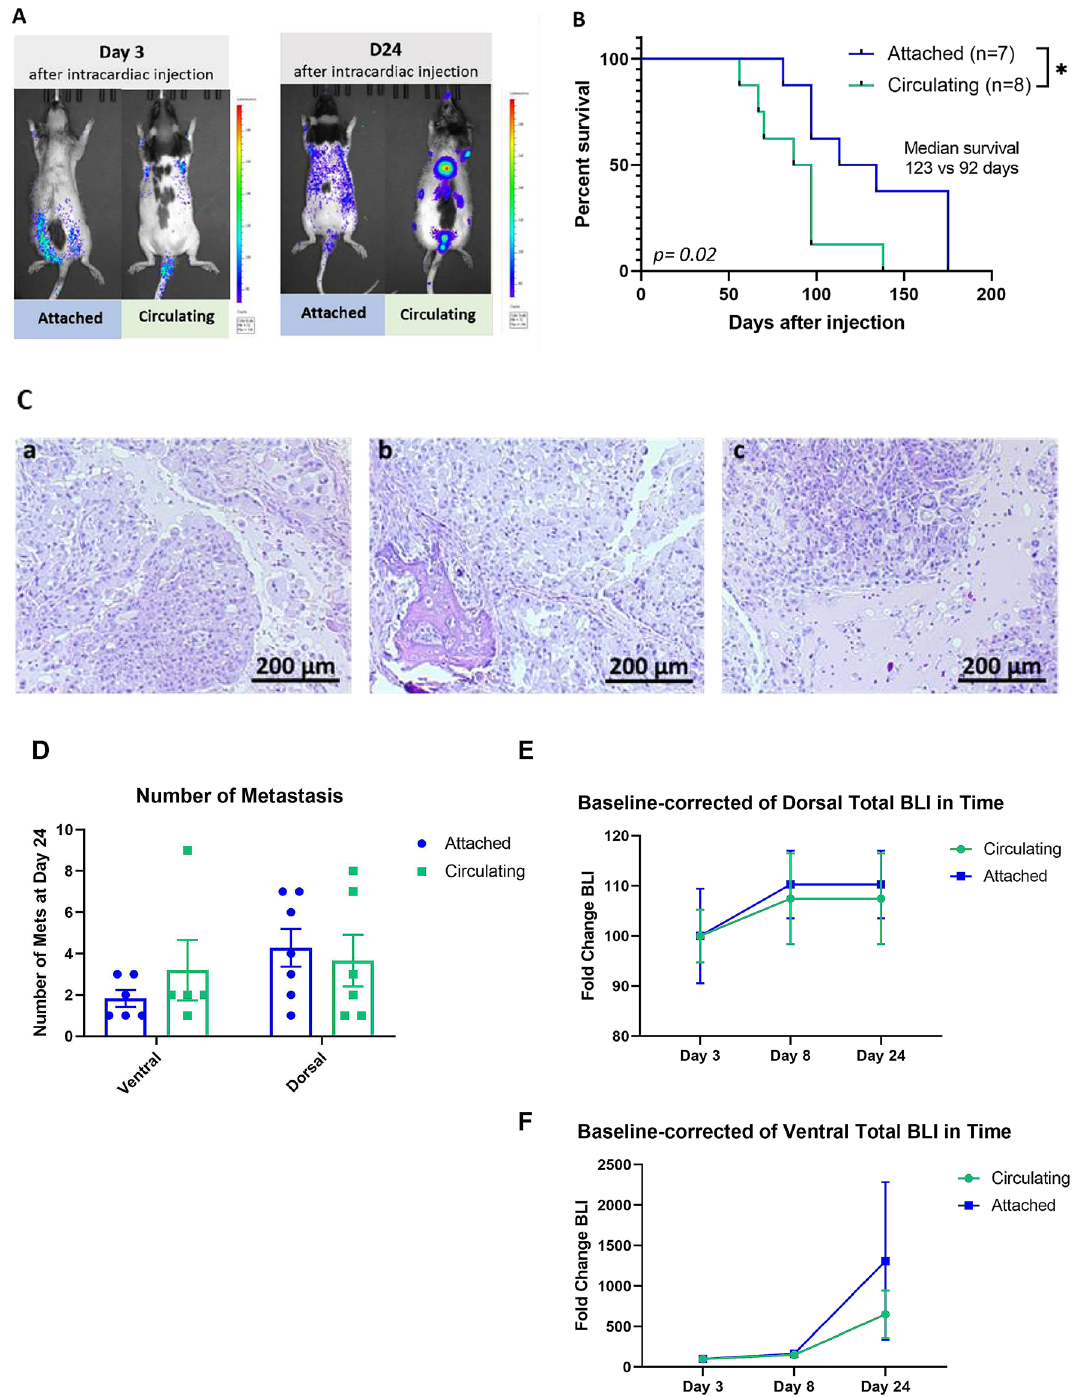
Figure 7. Lung cancer cells isolated from circulation lead to more metastatic disease and shorter survival than adherent cancer cells. 5 × 10 5 cells seeded in attached cell culture conditions or subjected to circulation for 72 h were injected in the left ventricle of RNU rats, and the distributions of the cells and the metastasis were monitored through bioluminescence. ( A ) After 24 days post injection, the group injected with cells subjected to circulation developed higher number of metastatic deposits compared with the group of rats injected with cells under attached conditions. ( B ) Kaplan–Meier survival curve for rats with attached cells versus circulating cells. Rats injected with circulating cells survived on average 31 days less (attached cells n = 7; circulating cells n = 8) * p < 0.02 by long-rank test. ( C ) Hematoxylin and eosin staining of tissues with BLA signal. ( a–c ) Tissues from rats injected with circulating cells (jaw, spine, and knee) show formation of metastatic deposits in the jaw, spine, and knee. ( D ) Quantification of metastatic burden in rats as number of metastasis in rats intracardially injected with attached vs. circulating cells through bioluminescence imaging (BLI). ( E ) Baseline-corrected dorsal total BLI through time in attached versus circulating cells. ( F ) Baseline-corrected ventral total BLI through time in attached vs. circulating